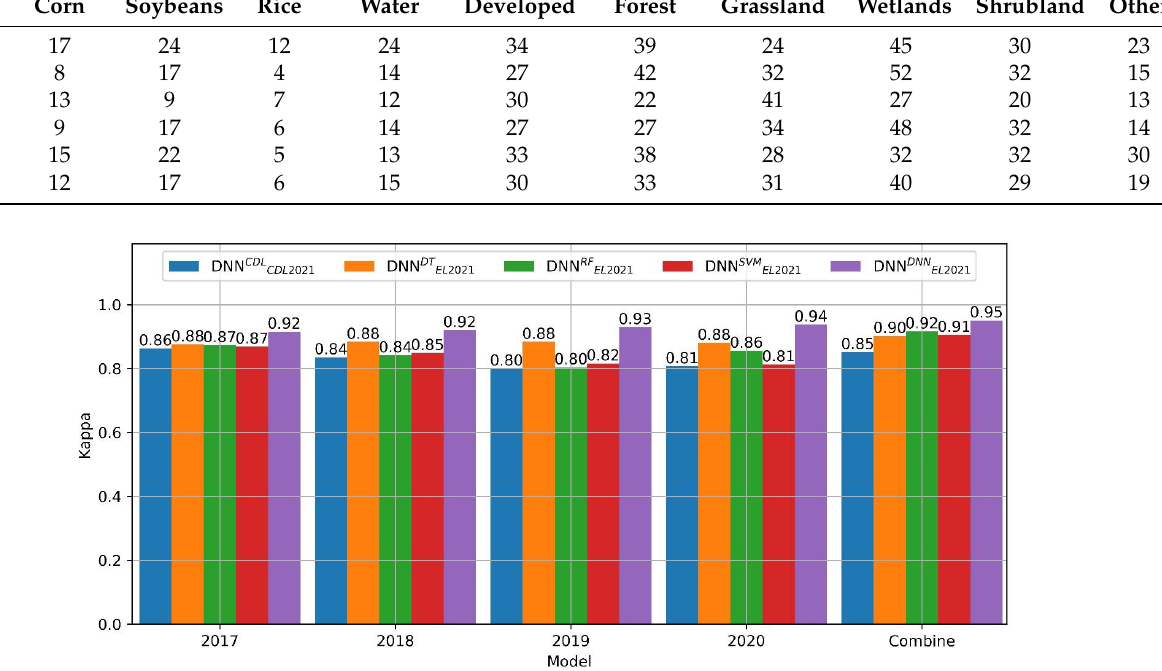
Figure 3. Kappa coefficients for models trained on candidate and ensemble learning samples. Each year represents the model trained on the samples of the corresponding year. The superscripts